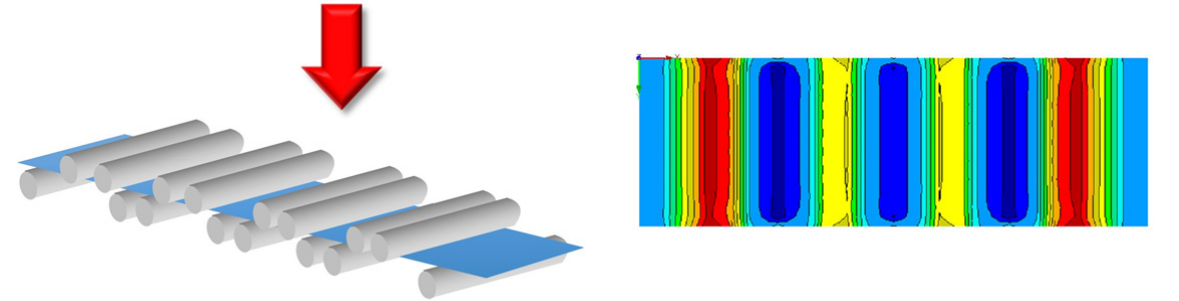
Fig. 7 Multi-point bending test set-up, stress distribution.